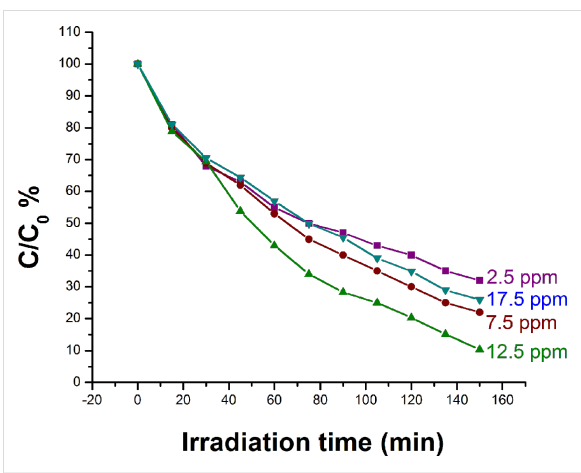
Figure 13: Effect of dye concentration on photocatalytic degradation.